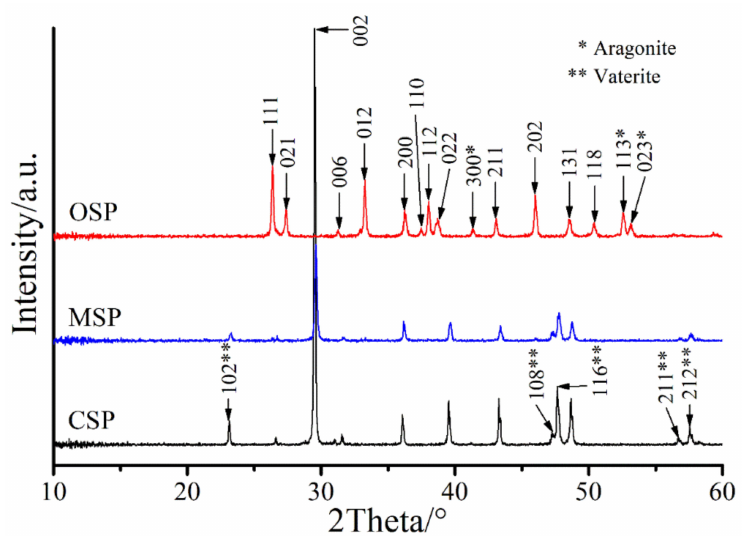
Figure 4. XRD patterns of the bivalve shell (CSP, MSP and OSP)